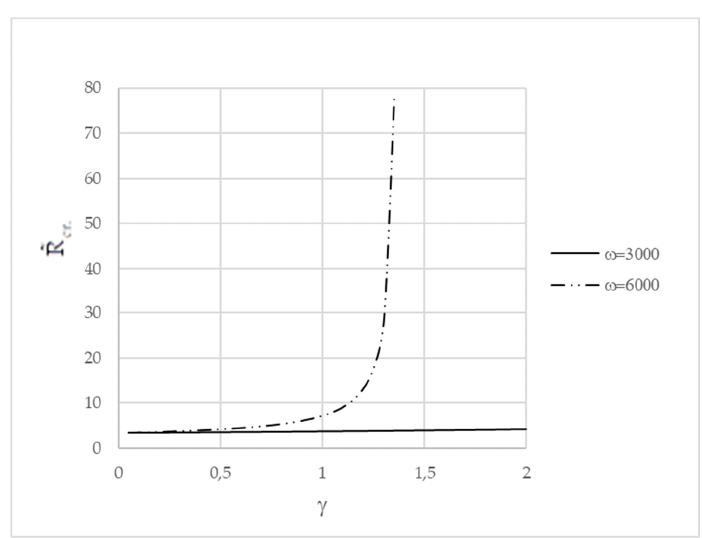
Figure 3. Critical Rayleigh number versus scaled Vadasz number at selected values of vibration frequency (Case 3: A = − 0.5).